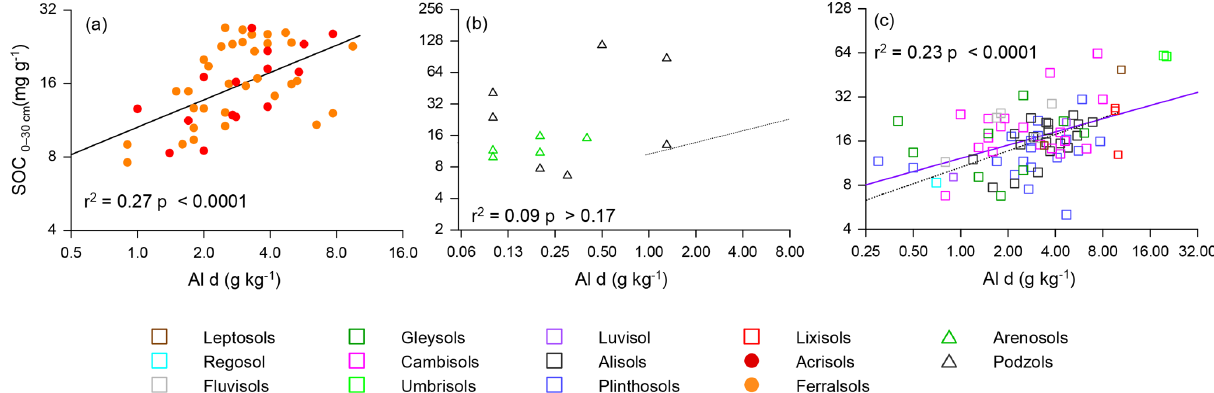
Figure 6. The association between soil organic C and dithionite extractable Al (Al d ) for the studied soils. The regression line for LAC soils (a) is repeated as a dotted line in (b) (arenic) and (c) (HAC) for comparison. Table 5. Summary of OLS regression coefficients for soil organic carbon and dithionite extractable Al. b SE β t p Lower Upper LAC soils: r 2 = 0 . 27, p< 0 . 0001, AIC = 30.26 intercept 2.36 0.100 – 23.69 0.000 0.372 HAC soils: r 2 = 0 . 23, p< 0 . 0001, AIC = 95.83 intercept 2.50 – log [Al] d 0.300 0.060 Arenic soils: r 2 = 0 . 09, p = 0 . 17, AIC = 37.05 intercept 3.42 0.433